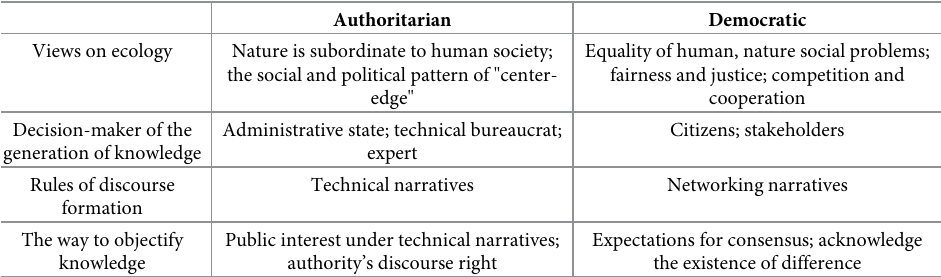
Table 1. Framework of the authoritarian & democratic ecopolitical